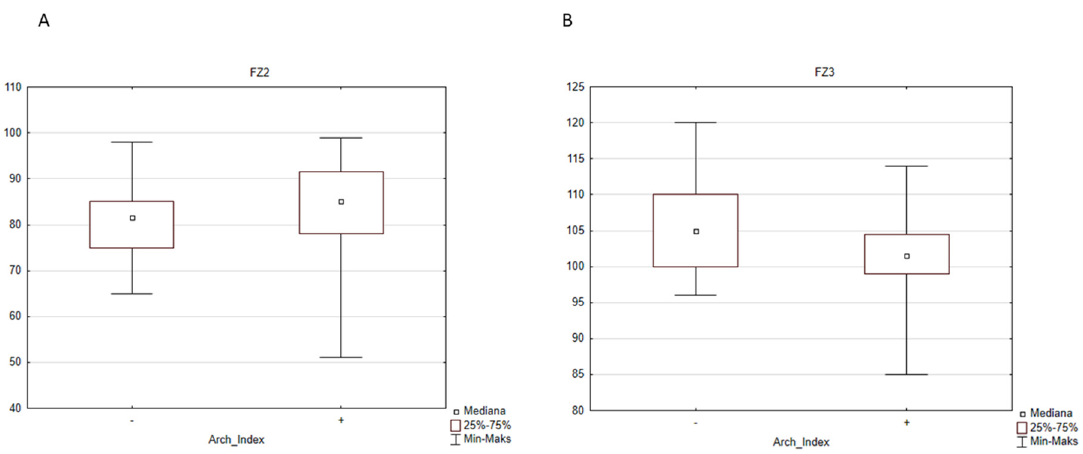
Figure 5. The influence of the type of the foot defined by the Arch Index on the parameters of the vertical ground reaction force: ( A ) FZ2 (middle of stance phase), “-“ normal foot (median = 81.5% BW), “+” flat foot (median = 85.0% BW), and ( B ) FZ3 (push-off), “-“ normal foot (median = 105.0% BW), “+” flat foot (median = 101.5% BW). BW, body weight.